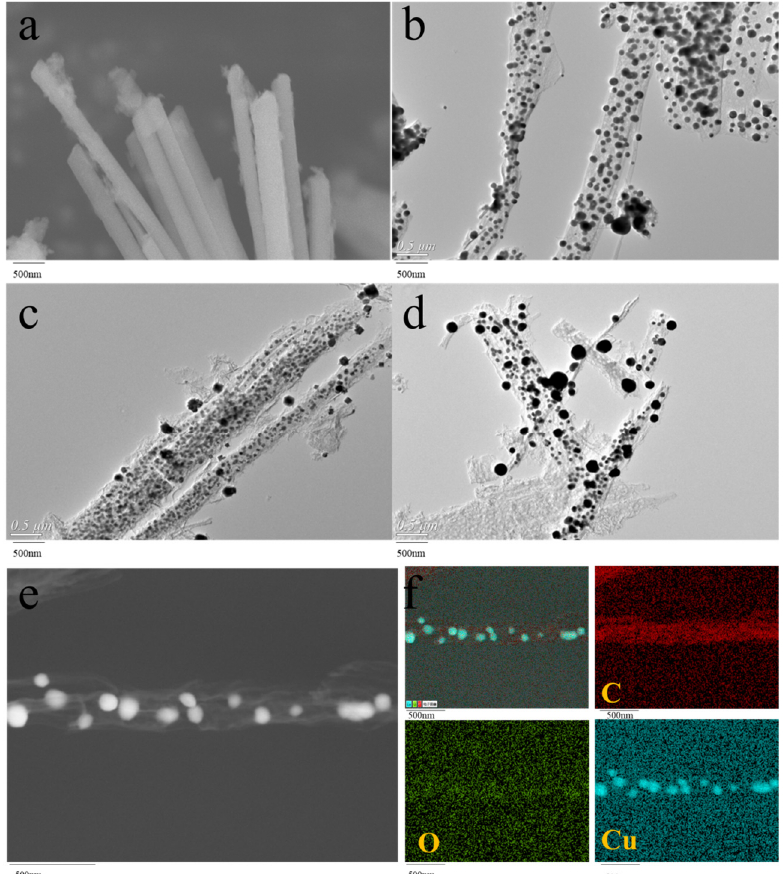
Figure 3. SEM and TEM images for the precursor and catalyst samples; SEM: ( a ) Cu(OH)(Hsal) · H 2 O; TEM: ( b ) Cu@C, ( c ) Cu@C-etching, ( d ) Cu@C-800; ( e ) TEM picture of Cu@C-800; ( f ) EDS element distribution map for the sample Cu@C-800.